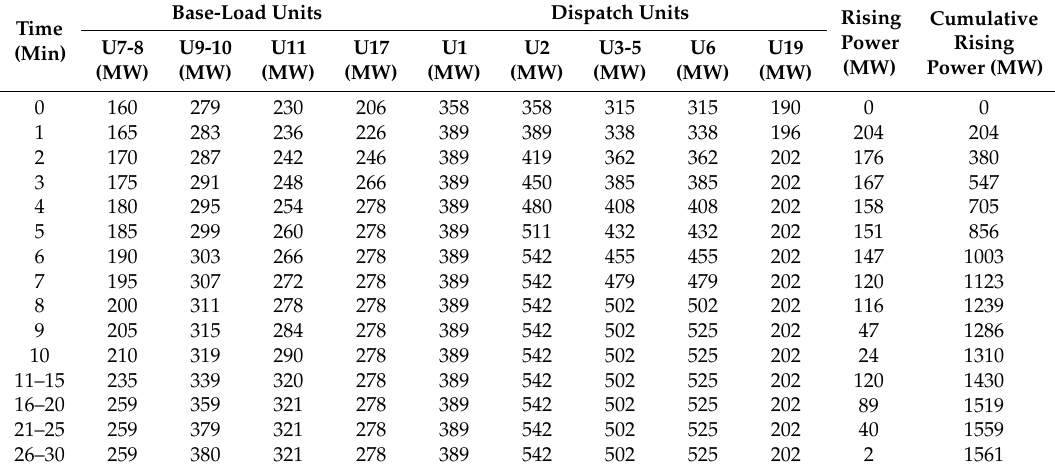
Table 4. The UC problem solved using the IPSO to increase power output by 1560 MW within 30 min.